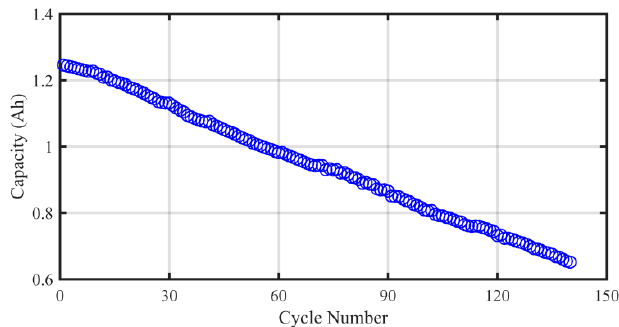
Figure 6. Capacity decay of the vanadium redox flow battery (VRB) cell during long-term cycling.